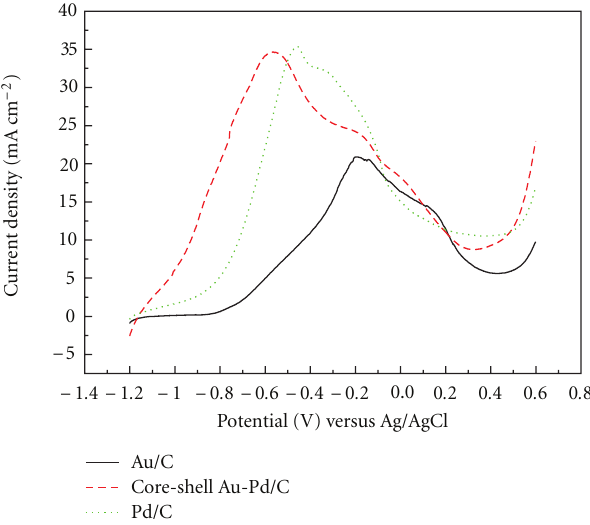
Figure 4: Absorption spectra of Au, core-shell Au-Pd, and mixed Au-Pd hydrosols before deposition on carbon.